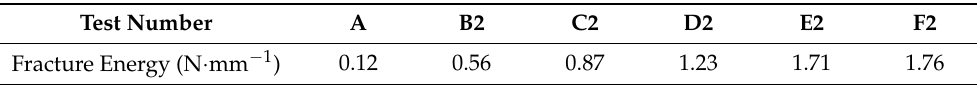
Table 4. Fracture